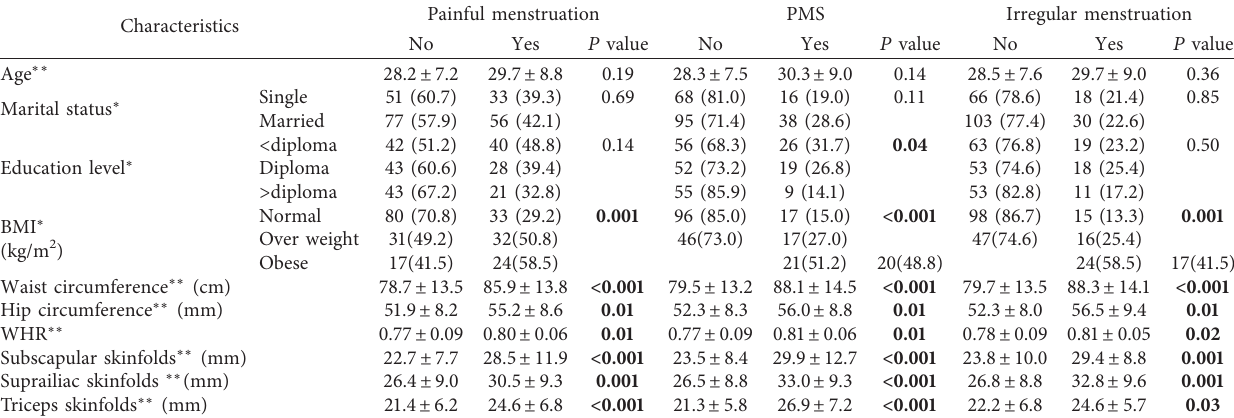
Table 3: Various menstrual disorders across sociodemographic and anthropometric parameters. Characteristics